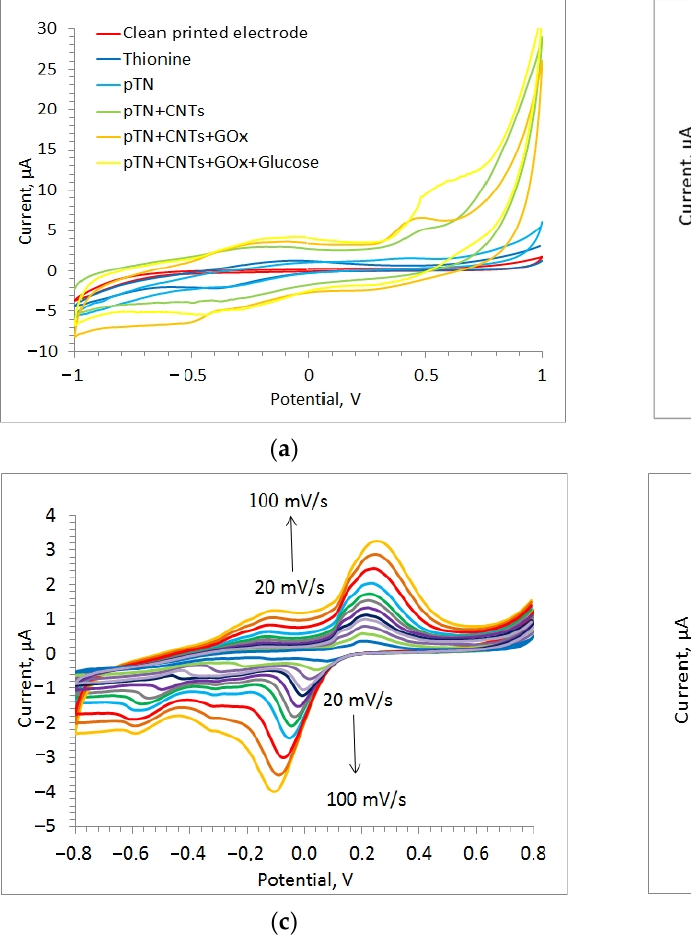
Figure 5. Electrochemical studies of the printed electrode with the developed conducting nanocomposite systems based on thionine: ( a ) cyclic voltammogram (CVA) at different stages of electrode modification; ( b ) dependence for determining the transfer coefficients ( α ) in p(TN)-CNTs; ( c ) CVA for the nanocomposite p(TN)-CNT system at different potential scan rates; ( d ) typical biosensor signal of a biosensor with a nanocomposite p(TN)-CNT material with the addition of different concentrations of glucose. Table 1. Heterogeneous rate constants of electron transfer and rate constants of interaction with GOx for the developed conducting polymers and their nanocomposites.